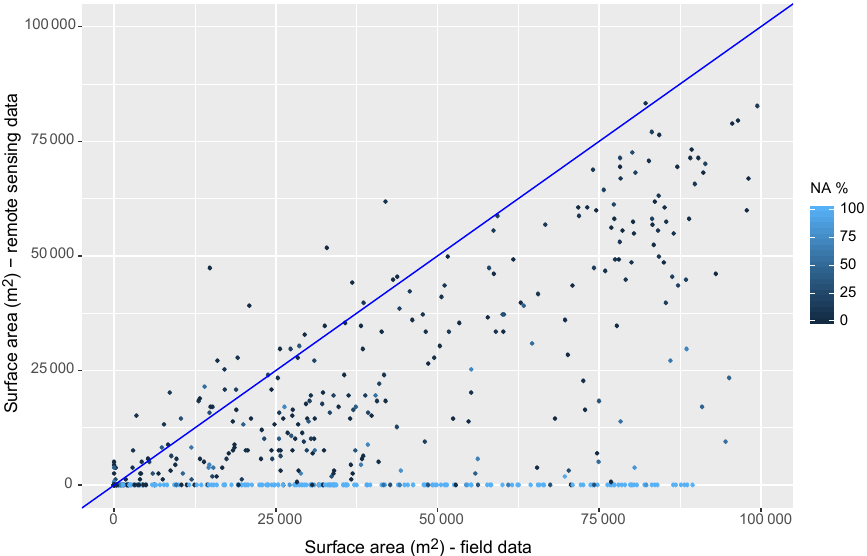
Figure 19. Remotely sensed surface areas with global surface water datasets (Pekel et al., 2016) vs. field data over 1999–2014 across all seven lakes. The percentage of NA pixels was calculated over each lake